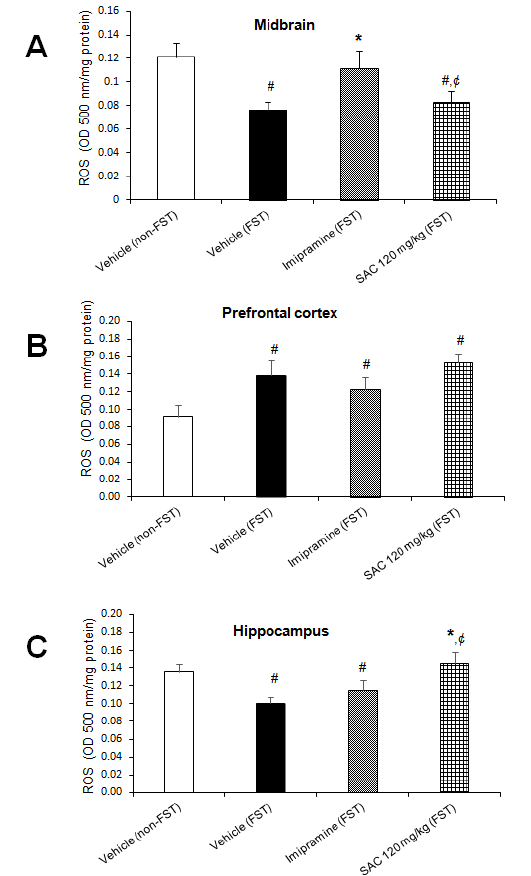
Figure 3. Effect of SAC on ROS levels in several brain regions of animals subjected to FST. The vehicle (non-FST), vehicle (FST), imipramine (FST) or SAC (120 mg/kg) were the treatment groups. SAC did not reduce the ROS amount in the midbrain ( A ), prefrontal cortex ( B ), or hippocampus ( C ) in the FST vs. vehicle-FST group. Results are expressed as mean ± SEM of 4–7 animals per group. The one-way ANOVA followed by post hoc Duncan’s test was used to analyze differences among the groups. (#) statistically different from vehicle non-FST group, p < 0.05, Duncan’s test; (*) statistically different from vehicle-FST group, p < 0.05; (¢) statistically different from imipramine (FST) group, p < 0.05, Duncan´s test. FST = forced swimming test; SAC = S-allyl cysteine; ROS = reactive oxygen species.